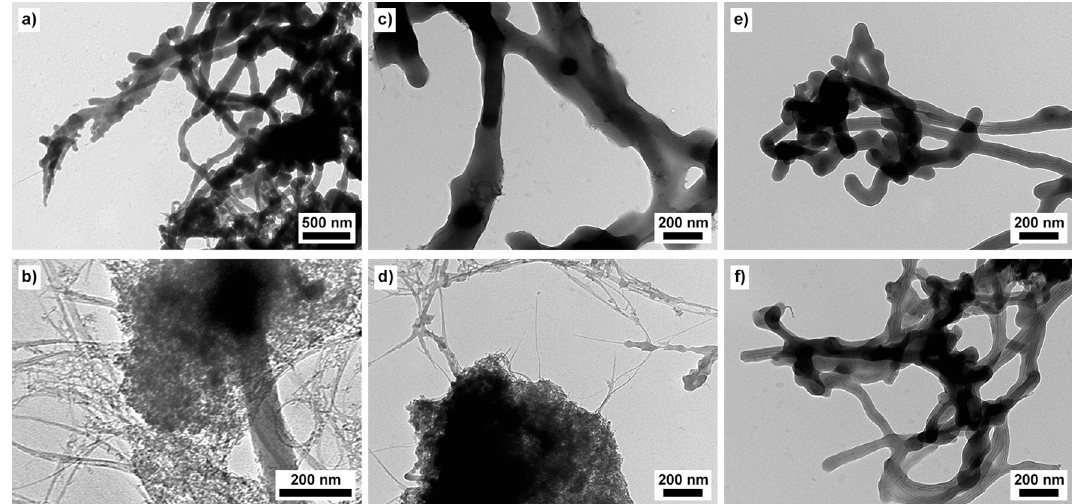
Figure 5. TEM images of fresh catalytic materials SW-1:2, SW-1:4 and MW-1:12 (a,c,e) and after the fifth cycle (b,d,f).